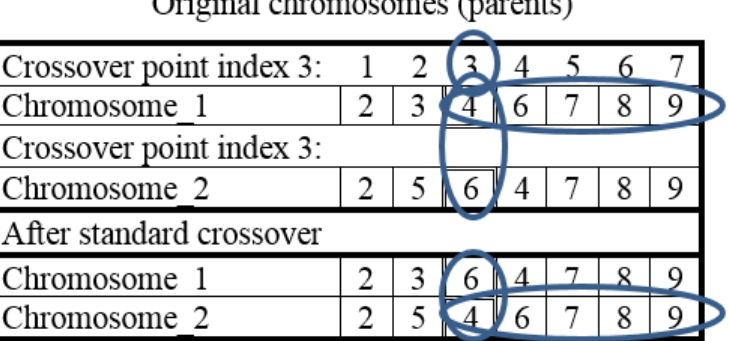
Figure 4. Standard crossover samples.